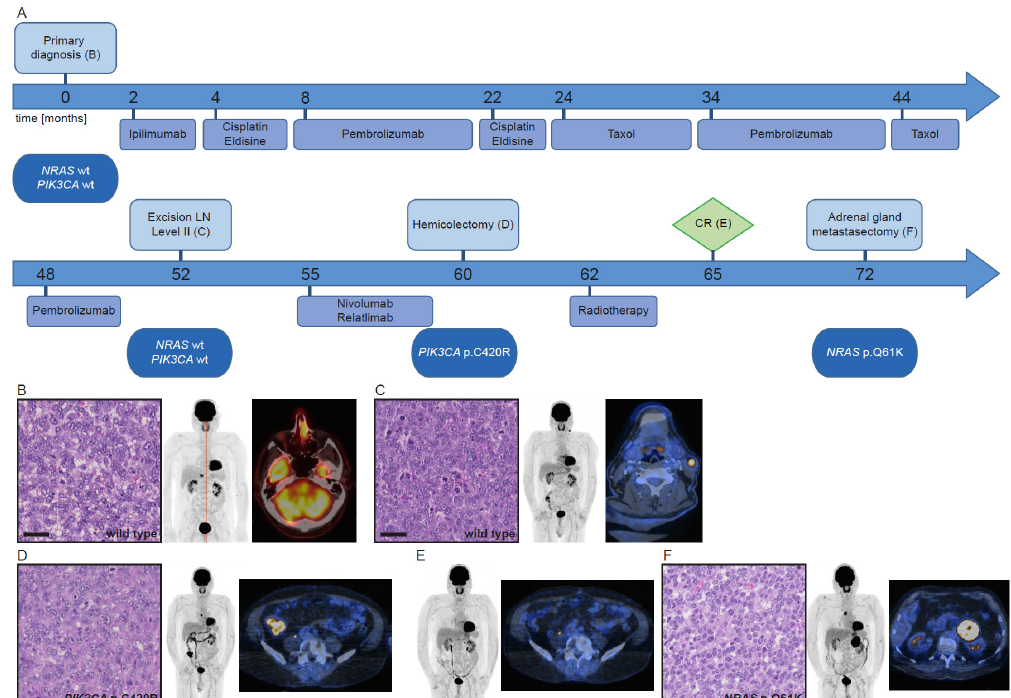
Figure 3. Course of disease, treatment, and morpho-molecular workup of patient 3. ( A ) Timeline. ( B ) Histology of the primary tumor; PET MIP display and fused PET/CT image at primary diagnosis. ( C ) Histology of the lymph node metastasis; PET MIP display and fused PET/CT image at progression after 34 cycles of pembrolizumab. ( D ) Histology of the colon metastasis; PET MIP display and fused PET/CT image at progression under nivolumab/relatlimab. ( E ) PET MIP display and fused PET/CT image at CR. ( F ) Histology of the adrenal gland metastasis; PET MIP display and fused PET/CT image at progression without therapy. Scale bar: 40 µm. wt: wild type, LN: lymph node, CR: complete remission.